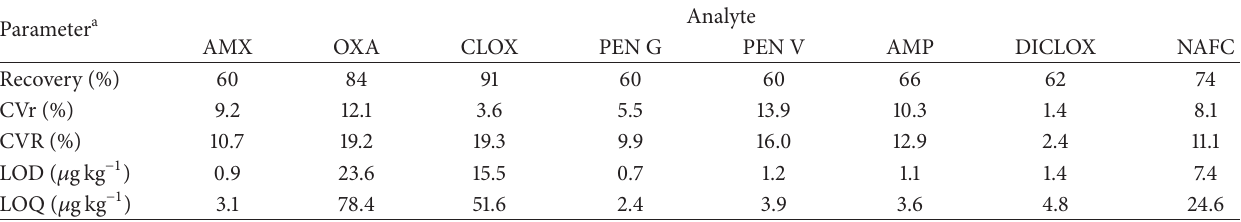
Table 5: Mean recoveries (ten samples), precision, limit of detection (LOD), and limit of quantification (LOQ) obtained for the determination of penicillin drugs in milk powder (infant formula) using NAFC-MAA-EGDMA-ACN polymer as MISPE sorbent, in combination with